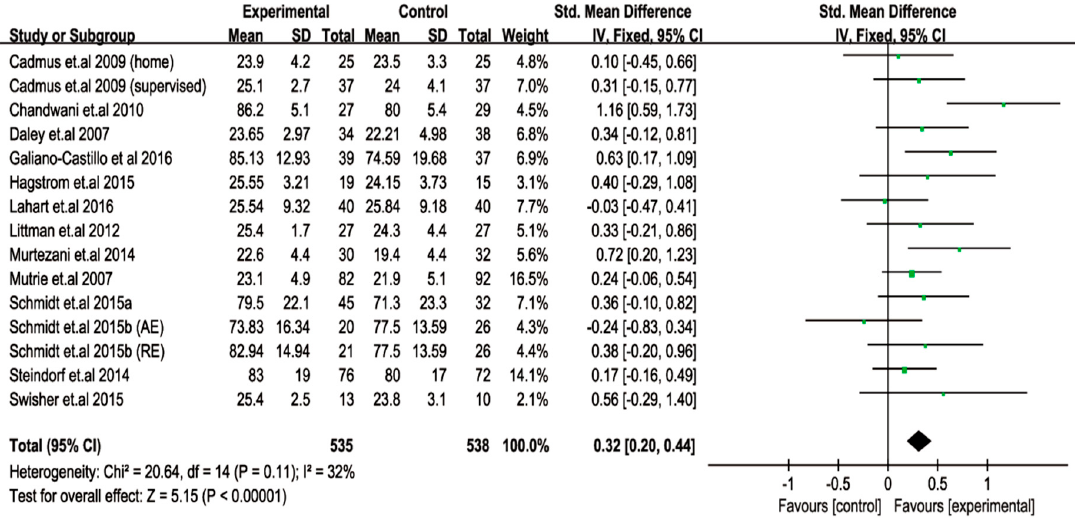
Figure 5. Pooled outcome of changes in physical function after exercise intervention in patients with breast cancer. SD, standard deviation; IV, inverse variation; CI, confidence internal; df, degrees of freedom.